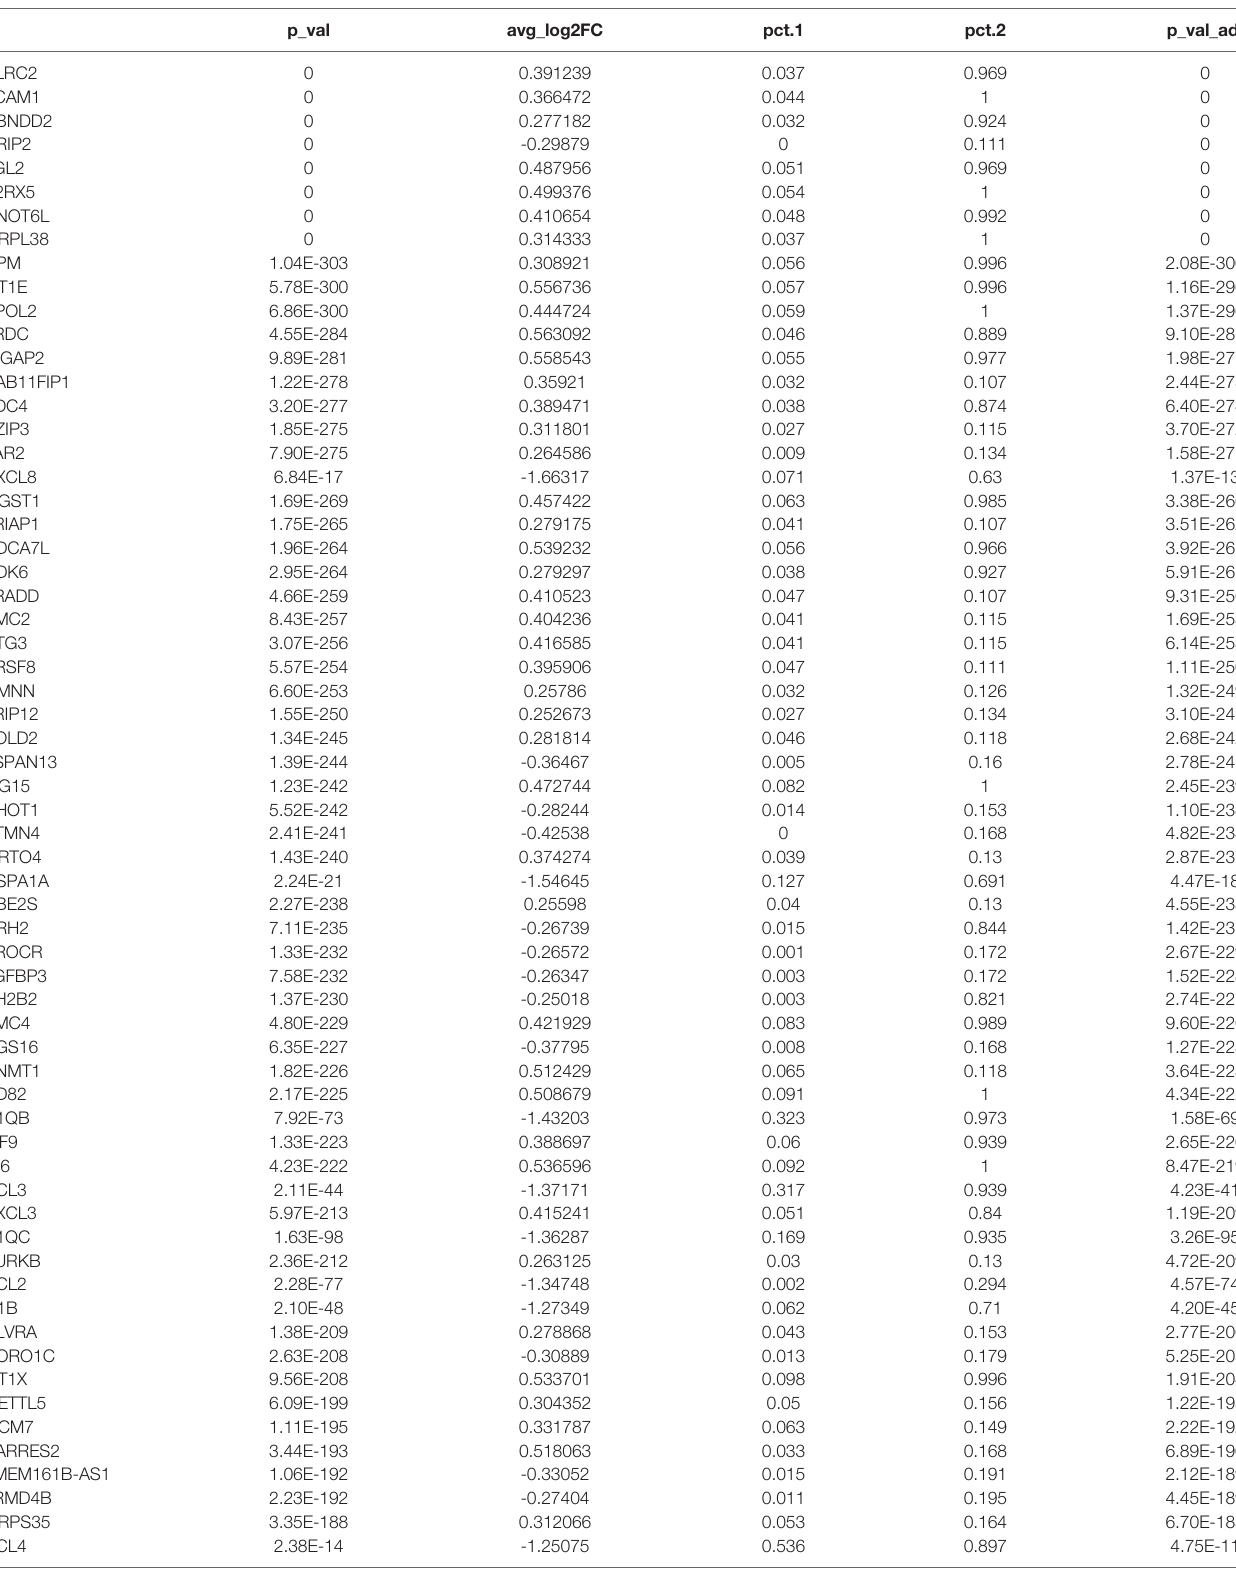
TABLE 3 | The DEGs between cancer and normal samples in macrophage cell